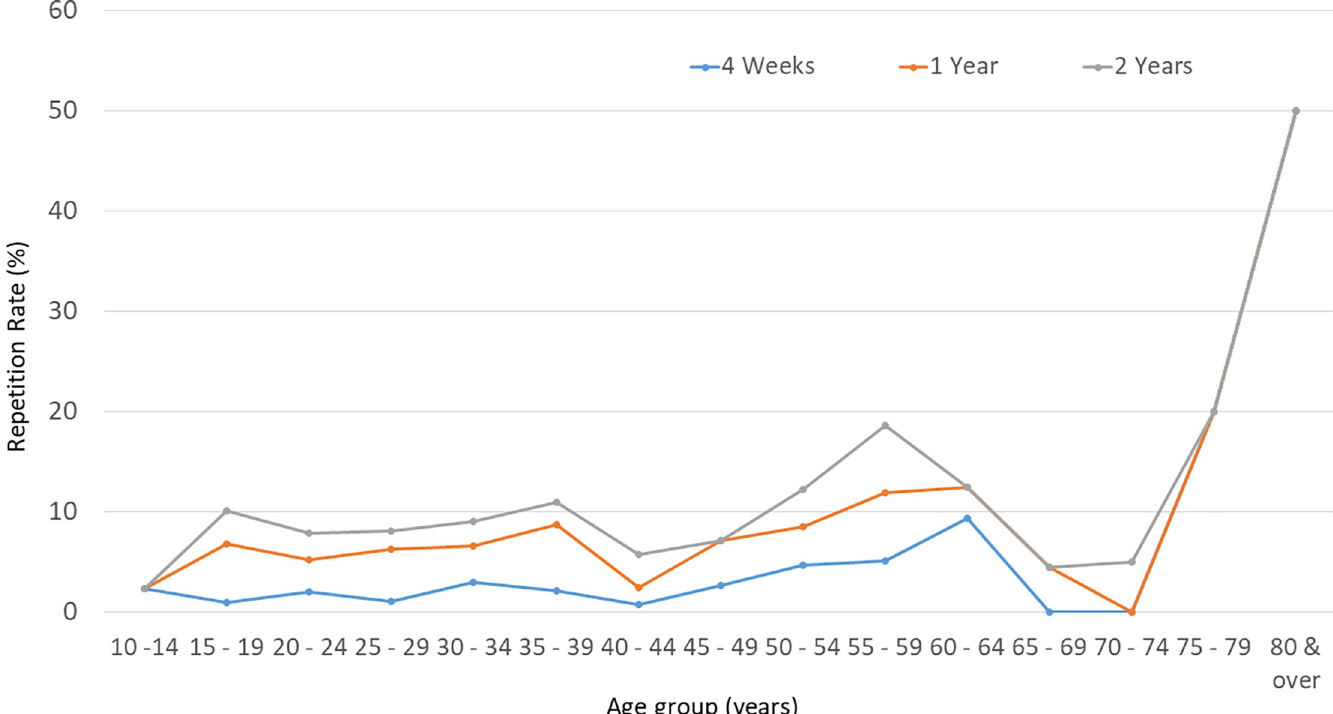
Fig 2. Rate of repetition among males, by age group, at four weeks, one year and two years. Repetition rate, 4 weeks: Number of males in a particular age group with repetitive events within 4 weeks from the indexed event/Male DSP patients in the particular age group of 2011 cohort. One-year: Number of males in a particular age group with repetitive events within a year from the indexed event/Male DSP patients in the particular age group of 2011 cohort. Two-year: Number of males in a particular age group with repetitive events within two years from the indexed event/Male DSP patients in the particular age group of 2011 cohort.